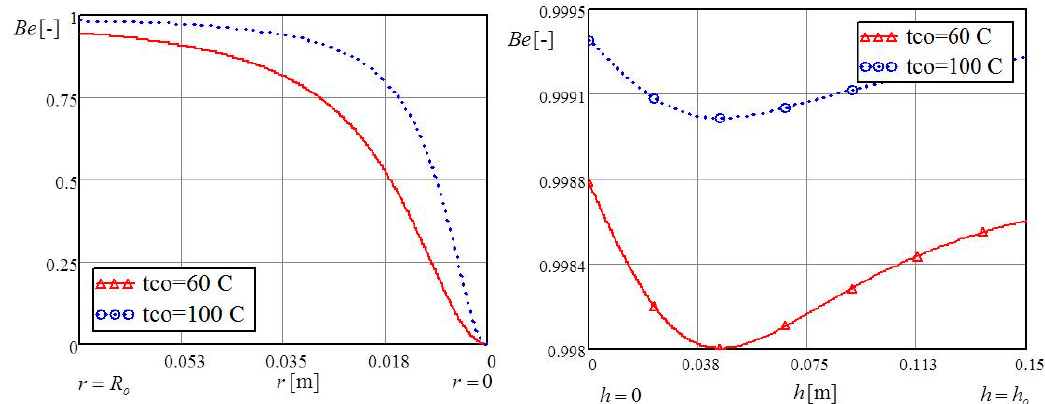
Figure 13. Bejan number of the individual influence of the bottom and the vertical annular